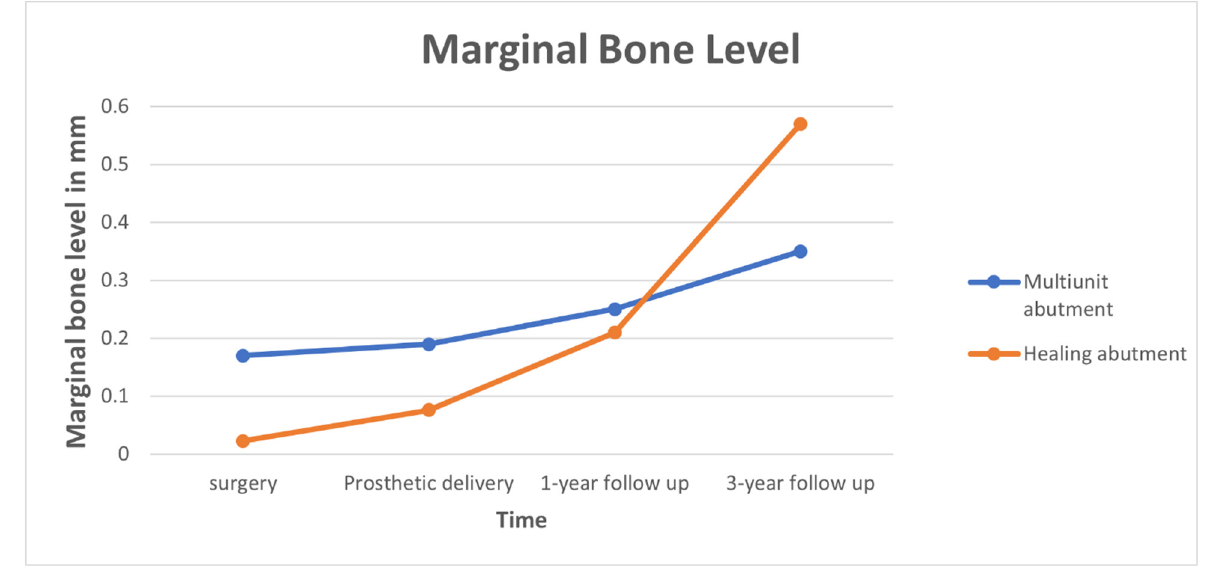
Figure 4. Marginal bone level in healing (red line) vs. multiunit (blue line) abutments at surgery and prosthetic delivery, and at the 1-year and 3-year follow-up evaluations.